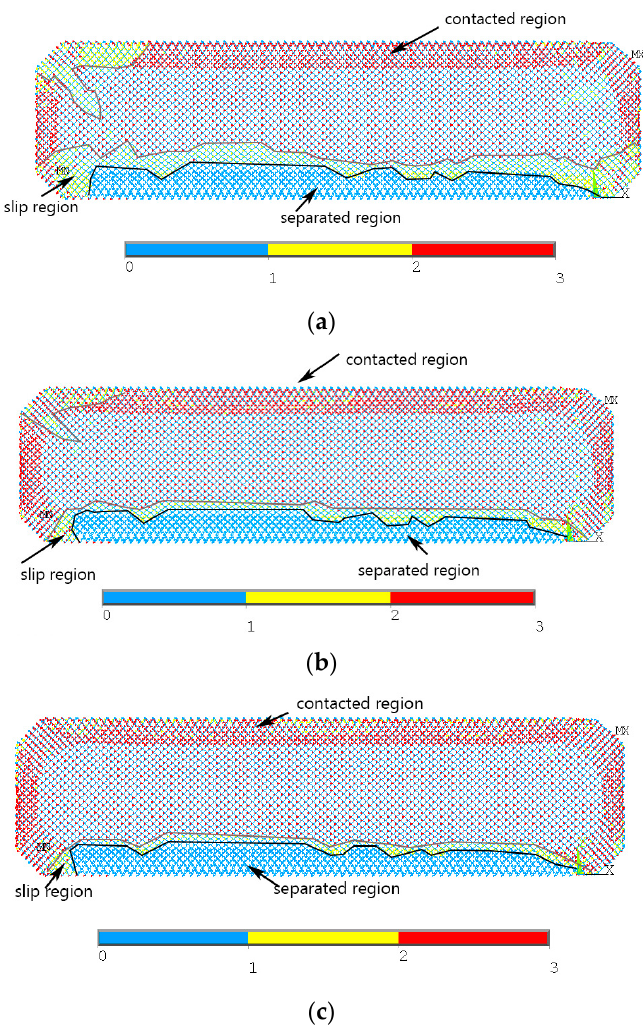
Figure 14. The separated region, slip region, and contact region of cable and membrane under different friction coefficients: ( a ) µ = 0.2; ( b ) µ = 0.44; and ( c ) µ =